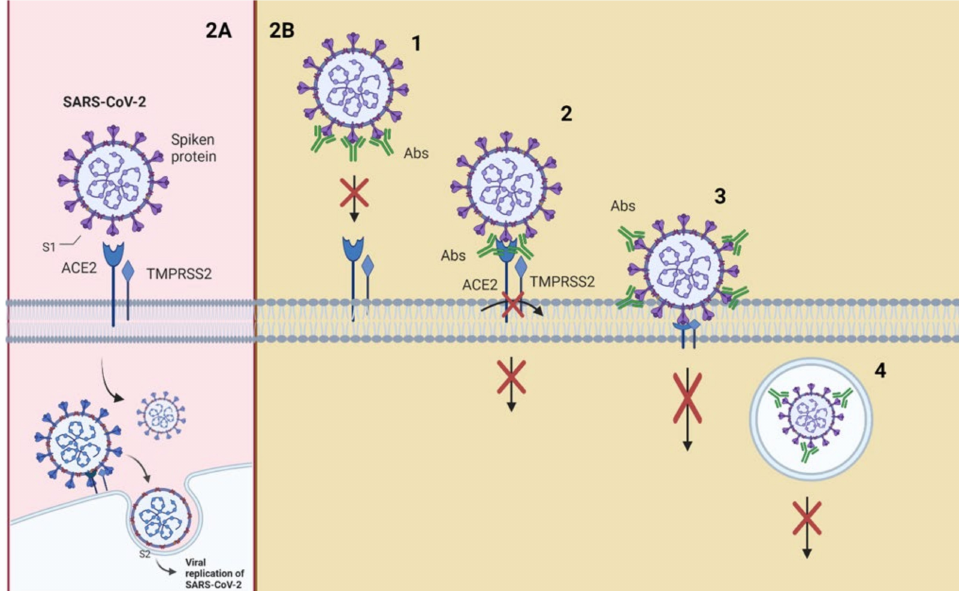
Figure 2. Interaction of SARS-CoV-2 with its receptors and neutralization mechanisms. ( A ) S1 contains the receptor-binding domain (RBD) and directly binds to ACE2 to gain entry into host cells. ( B ) Neutralizing mechanisms: (1) NAbs bound to the receptor-binding protein (S) and block its interaction with ACE2; (2) the virion establishes contact between its binding protein and the receptor on the cell surface, and NAbs block subsequent steps, such as binding to a coreceptor; (3) the virion is about to fuse with the cell membrane, but NAbs are bound to proteins that are not essential for cell receptor binding but exert conformational changes that do not allow virus internalization with the cell membrane; (4) NAbs prevent the virion from merging its envelope with the vesicular membrane (endosome) and begin viral replication, and the binding of the antibody to the virus inhibits the conformational changes necessary for membrane fusion. Abbreviations: ACE2, angiotensin-converting enzyme 2; TMPRSS2, transmembrane serine protease